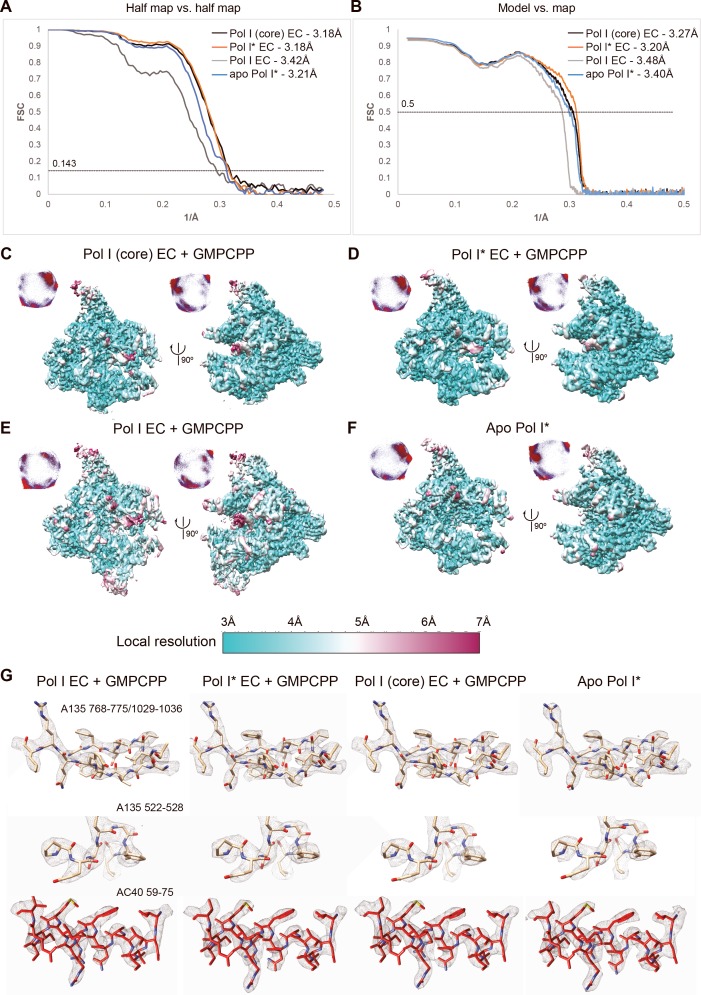
Average and local resolution estimates for the reconstructions.(A) Fourier-shell correlation (FSC) curves for the reconstructions. (B) FSC curves for the models versus experimental maps. (C–F) Local resolution estimates for all the reconstructions and angular distribution plots. (G). Representative densities.